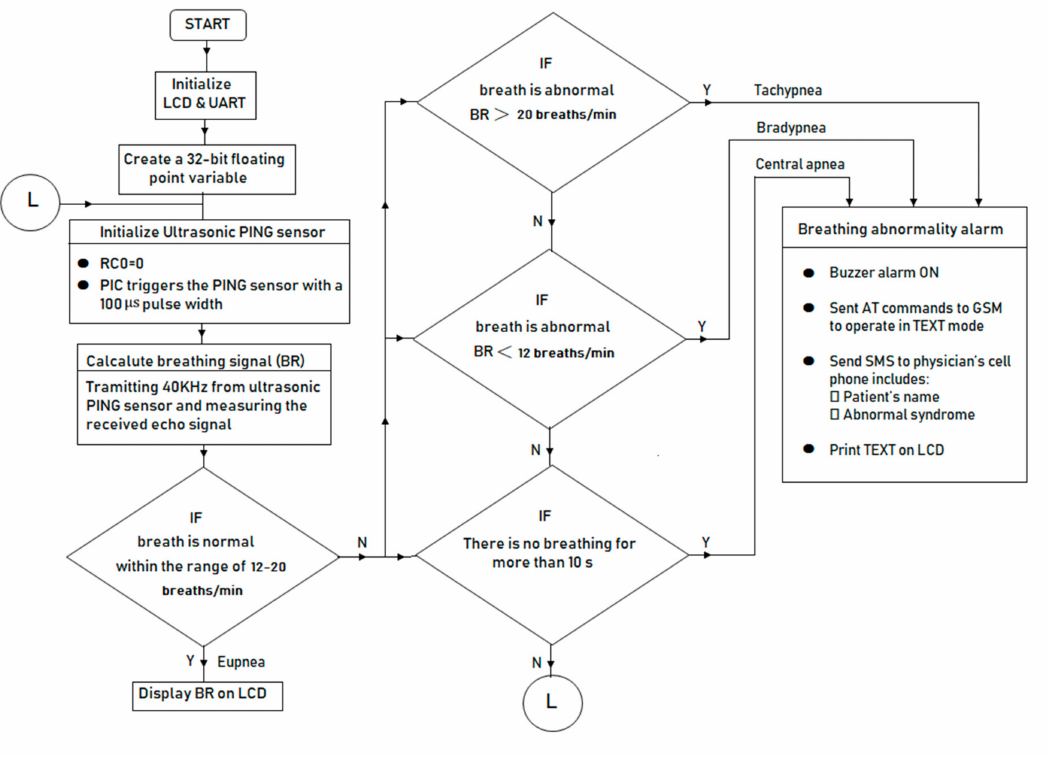
Figure 4. Flowchart of the proposed monitoring